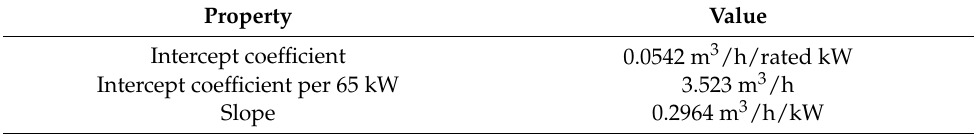
Table A5. C65 microturbine fuel curve [44].